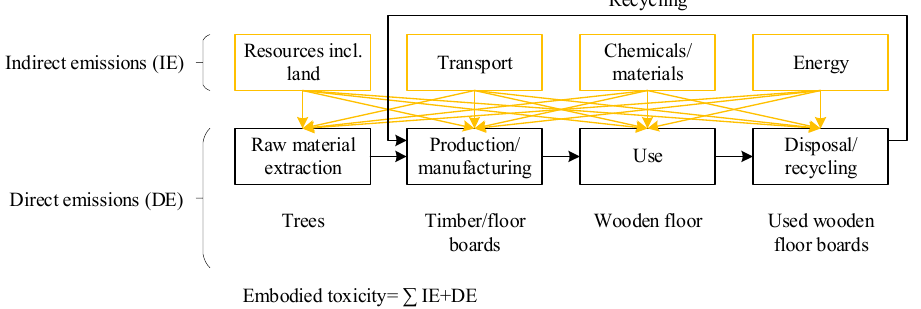
Figure 1. Visualization of the life cycle stages and emission types accounted for when calculating the toxicological footprint of wood.